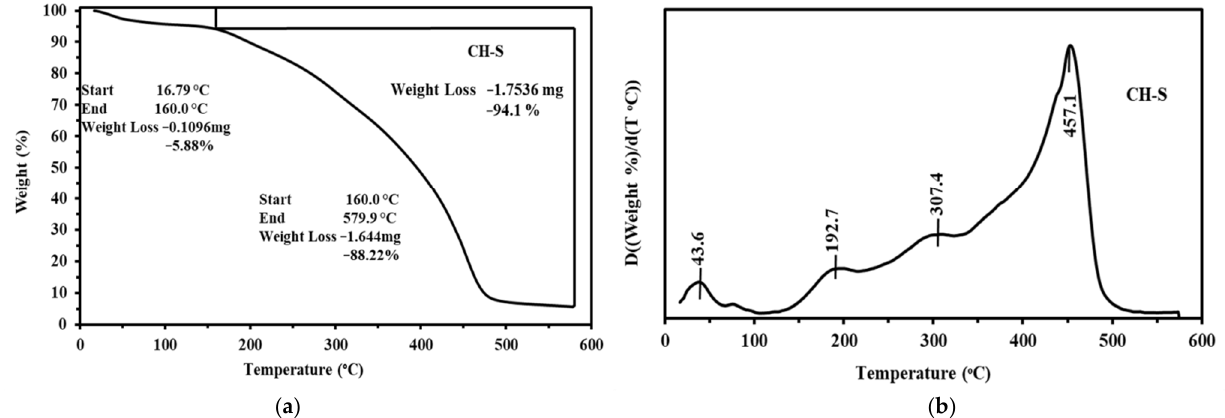
Figure 2. TGA ( a ) and DTG ( b ) for sulfonated chitosan sorbent (CH ‐